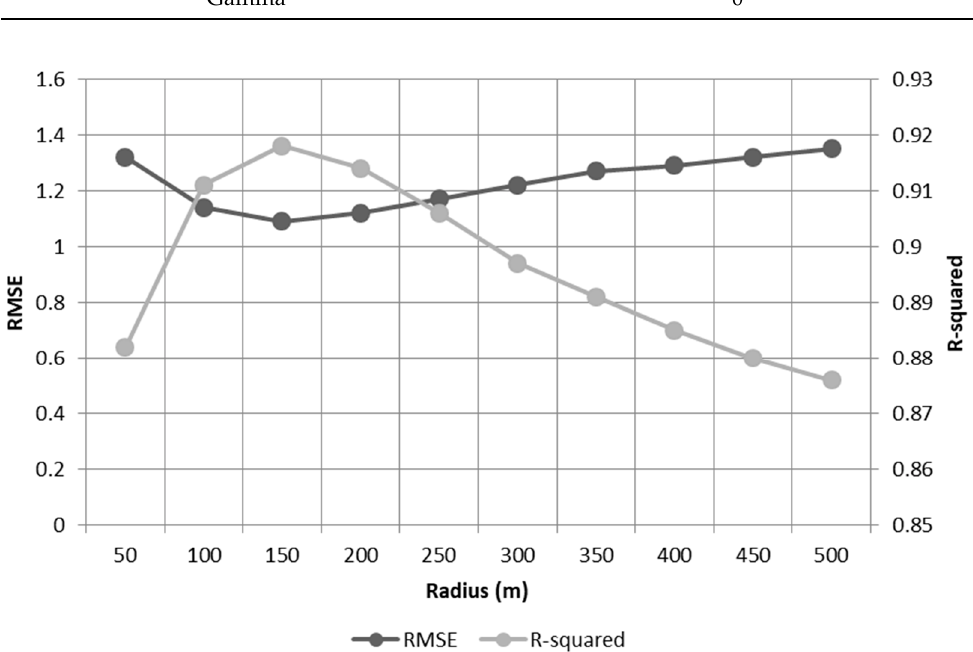
Figure 6. Sensitivity of prediction